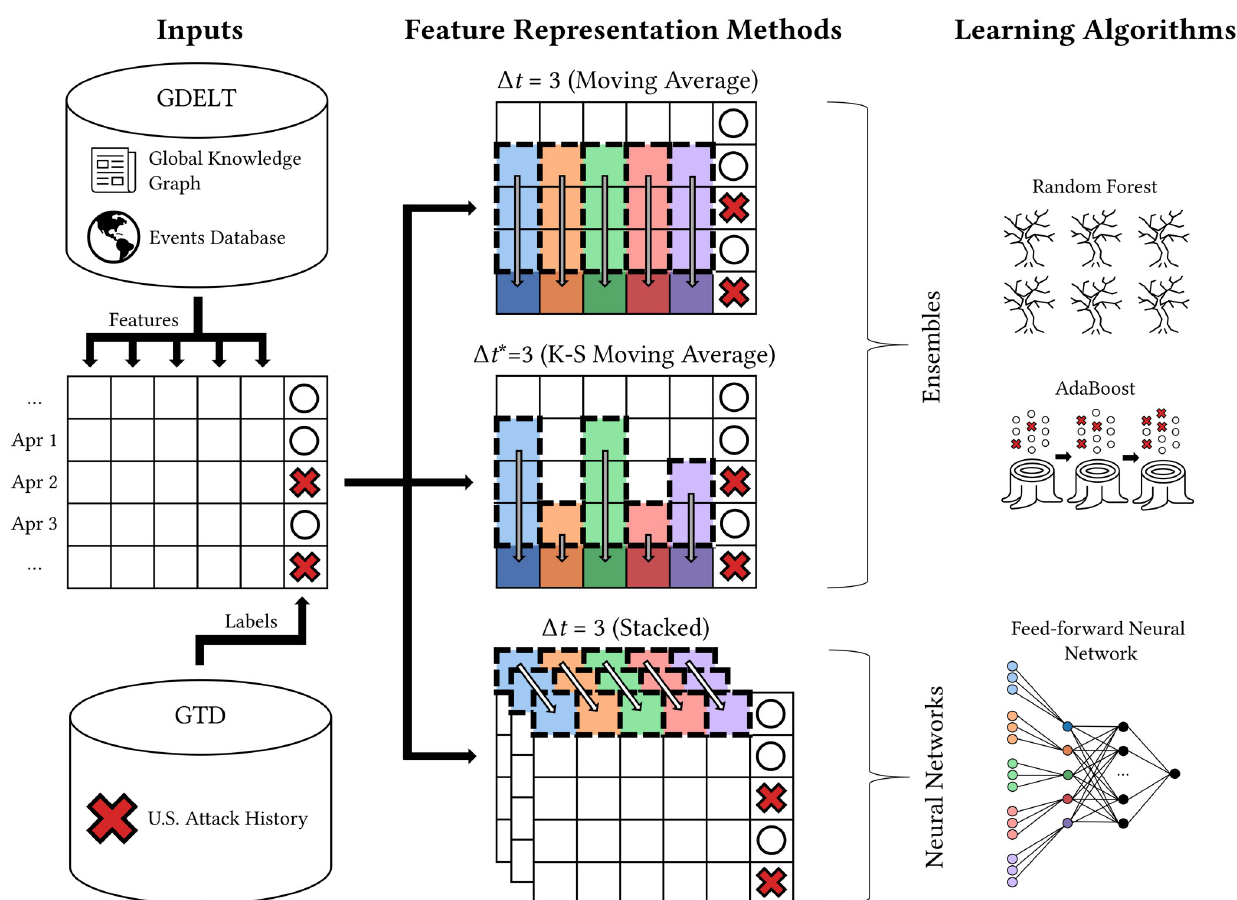
Fig 1. Locations of the 229 terrorist attacks perpetrated in the United States between Feb. 18, 2015, and Dec. 31, 2018, as recorded in the Global Terrorism Database.